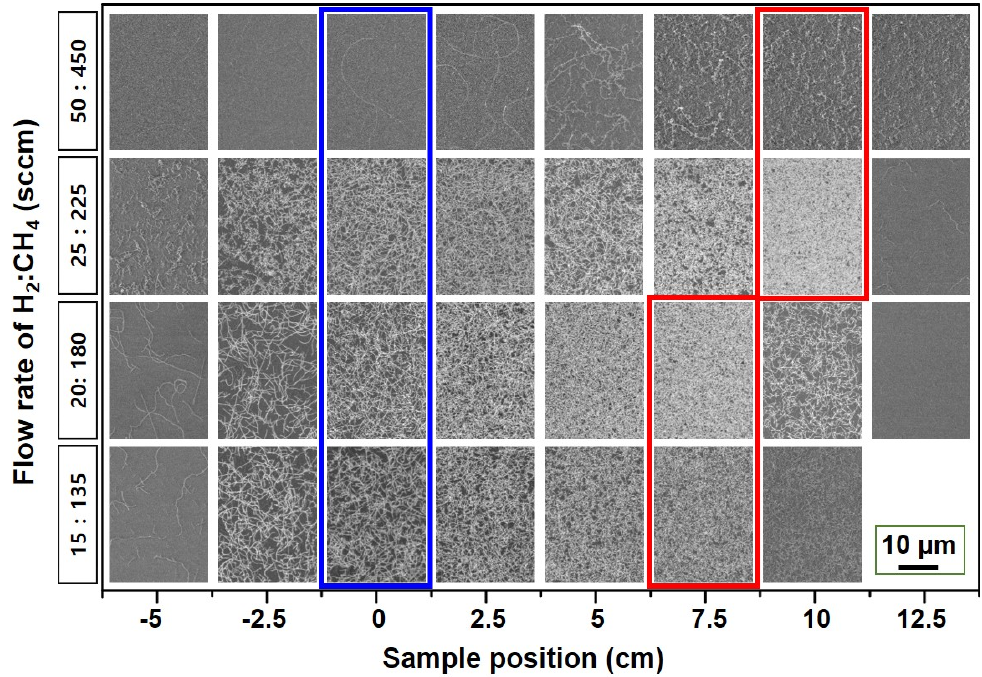
Figure 2. HRSEM images showing the growth results for SWNTs, depending on gas flow rate and sample position. SEM images from the central region and maximum-synthesis-yield regions are highlighted with blue and red boxes, respectively.